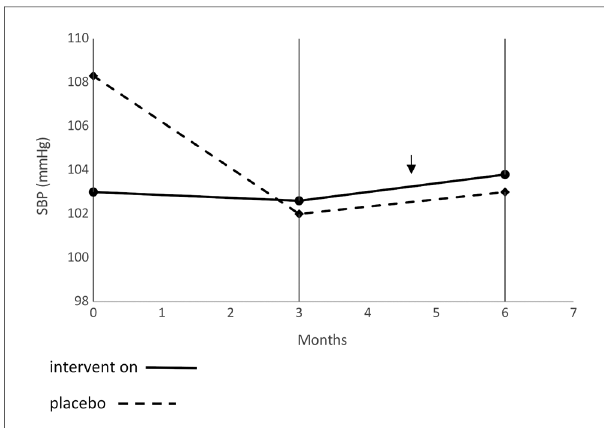
FIGURE 3 Evaluation of systolic blood pressure throughout the study